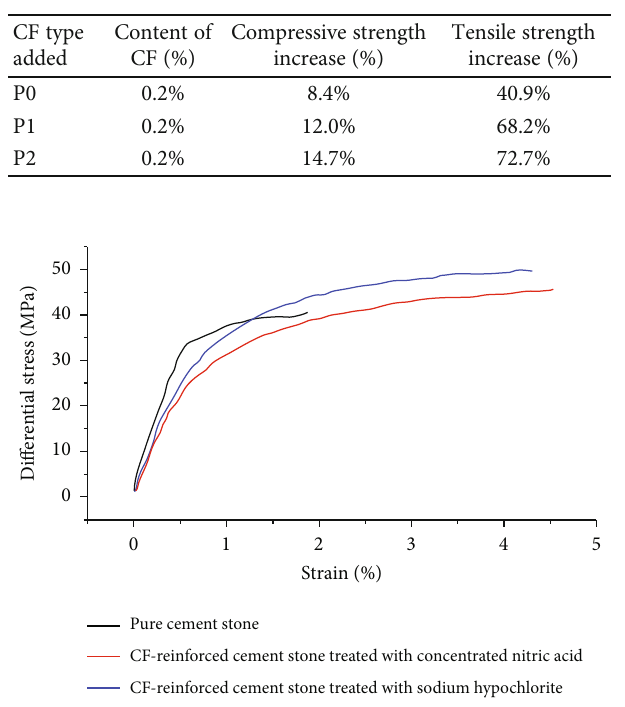
Figure 4: Triaxial stress-strain curves of cement stone.